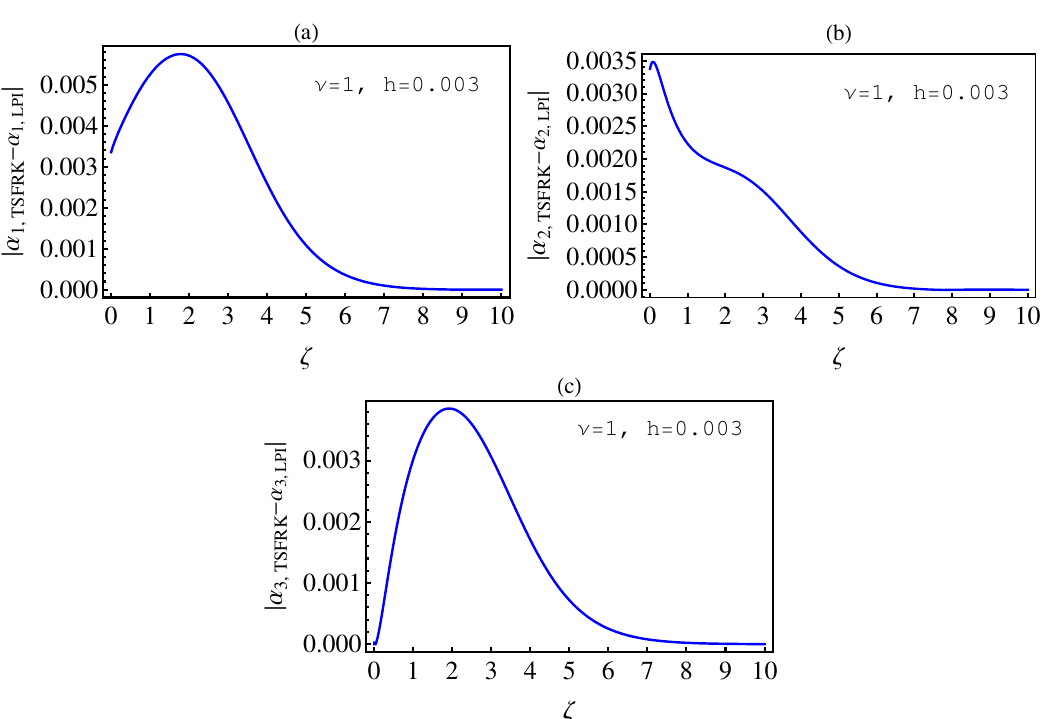
Figure 4. The absolute error between the numerical solutions of (2) to (4) based upon the LPI and the TSFRK for ν = 1, h = 0.03, m = 21, λ = 2, (cid:101) = 1, µ = 2, δ = 1 and for the initial values